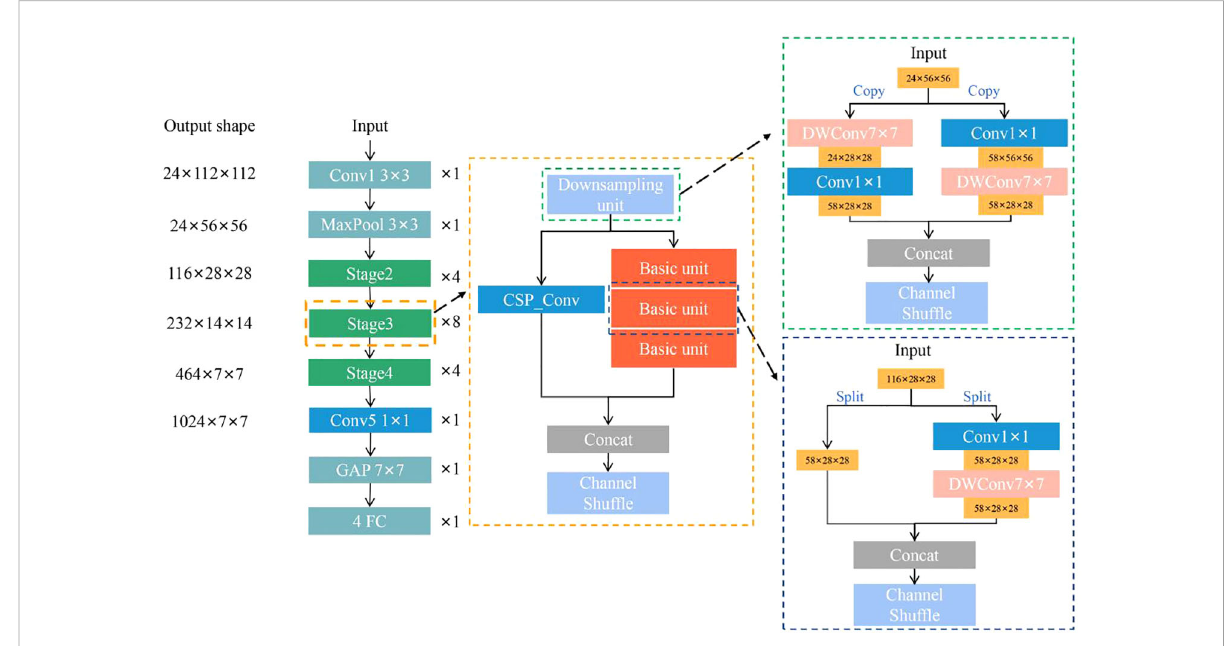
FIGURE 3 Architecture of Shuf fl